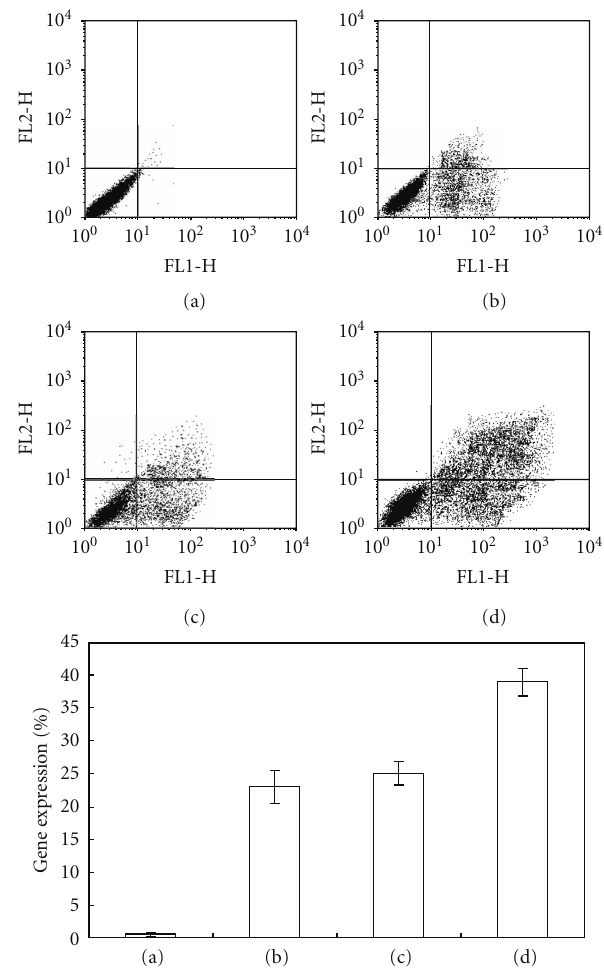
Figure 7: Flow cytometry analysis of KCs transfected by plasmid EGFP in vivo . Gene expression was examined after 48 h following injection. (a) Naked DNA, (b) Lipofectamine-DNA, (c) DNA-NPs, and (d) MAN-DNA-NPs (mean ± SD, n = 3). (Figure 2) and the optimum MAN-DNA-NPs had a Zeta potential of − 15.46 mV (Table